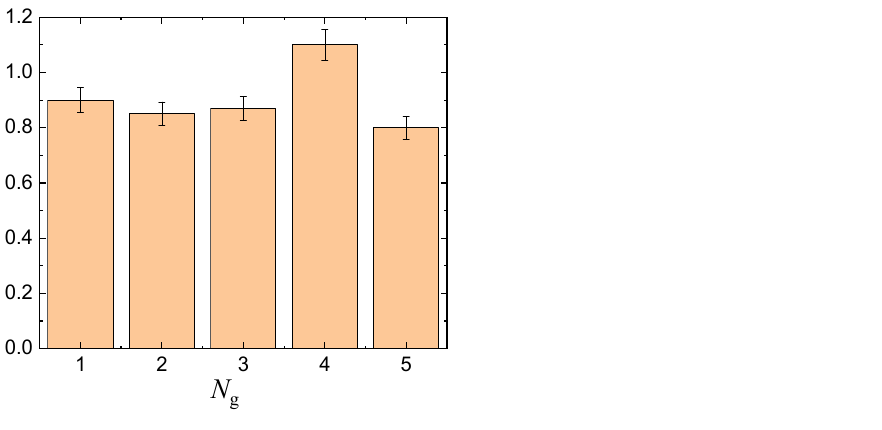
Figure 8. Ratio of droplet motion resistant forces to gravity ( N g —group number) [49]: 1—0.04 ≤ R m ≤ 0.09 mm; 2—0.09 ≤ R m ≤ 0.16 mm; 3—0.16 ≤ R m ≤ 0.23 mm; 4—0.23 ≤ R m ≤ 0.35 mm; 5—0.35 ≤ R m ≤ 0.50 mm.